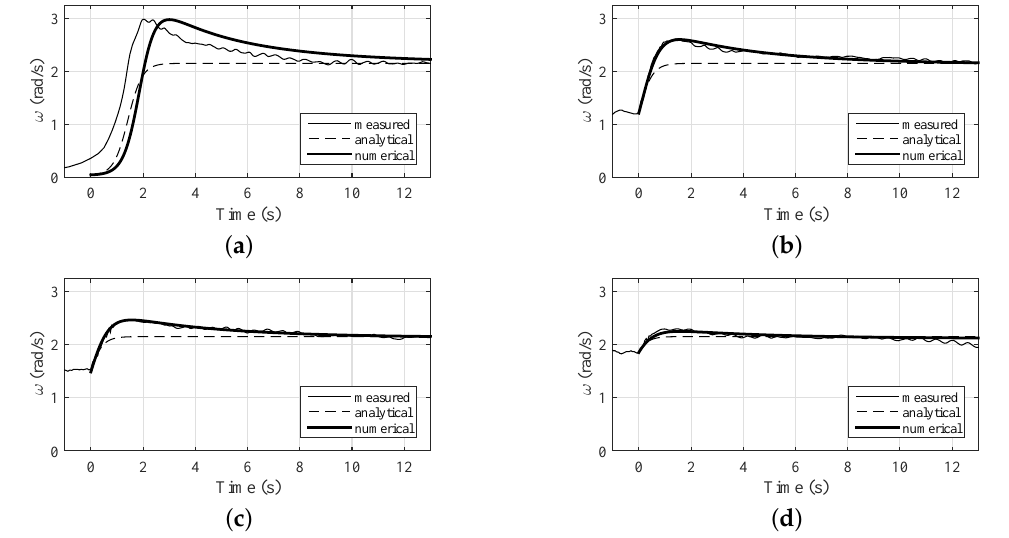
Figure 4. Comparison of model predictions with measured results. Cases are specified in Table 3.